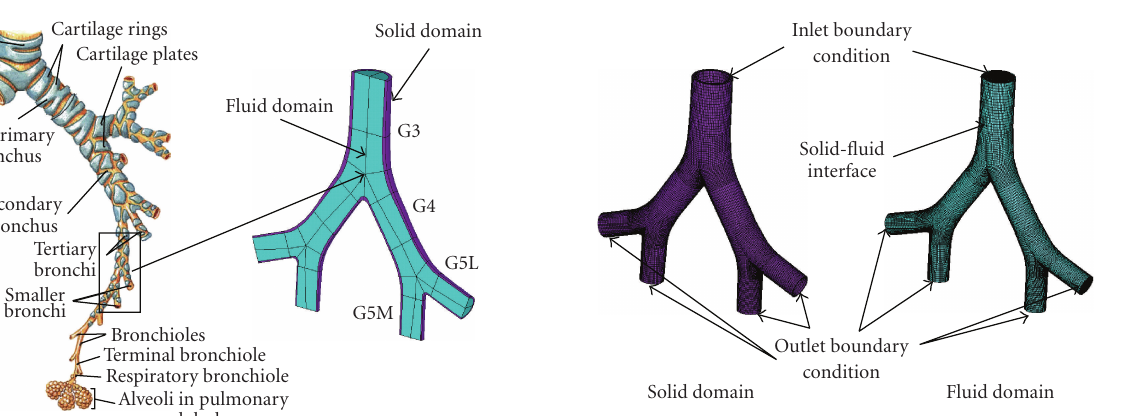
Figure 3: The mesh-converged finite-element model of the airway generations 3 to 5 and the boundary conditions for this